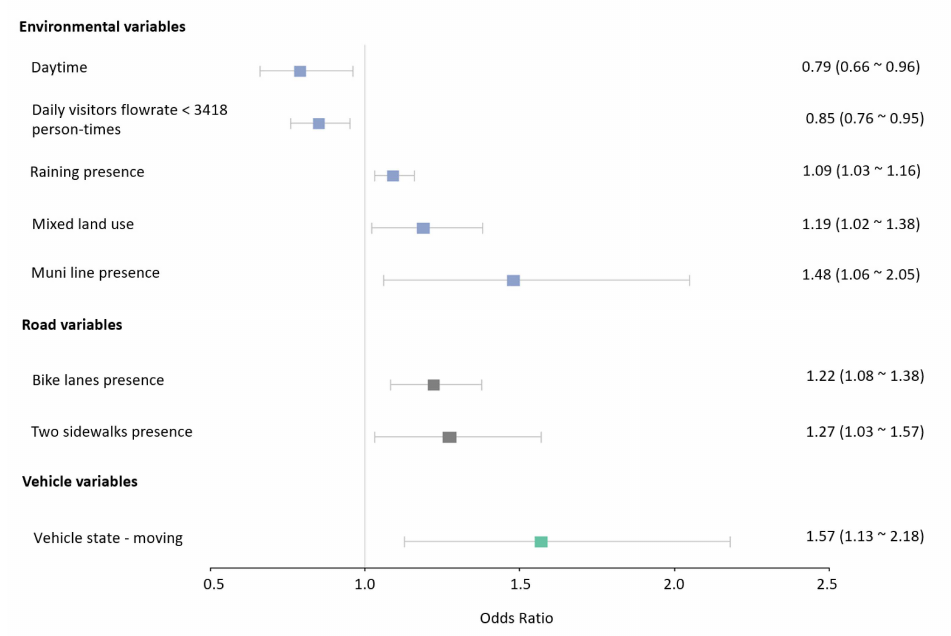
Figure 3. Odds Ratio of the influencing factors for crash severity in the autonomous